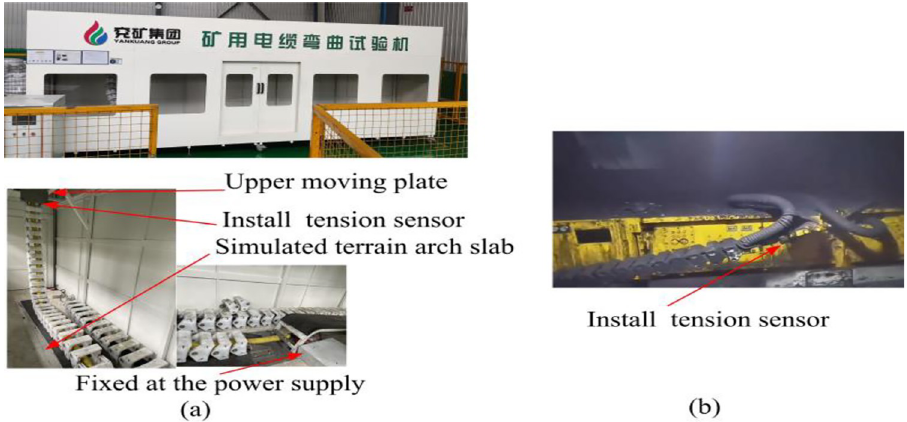
Fig 13. Indirect acquisition of cable tension by test methods: (a) cable bending test; (b) industrial test.